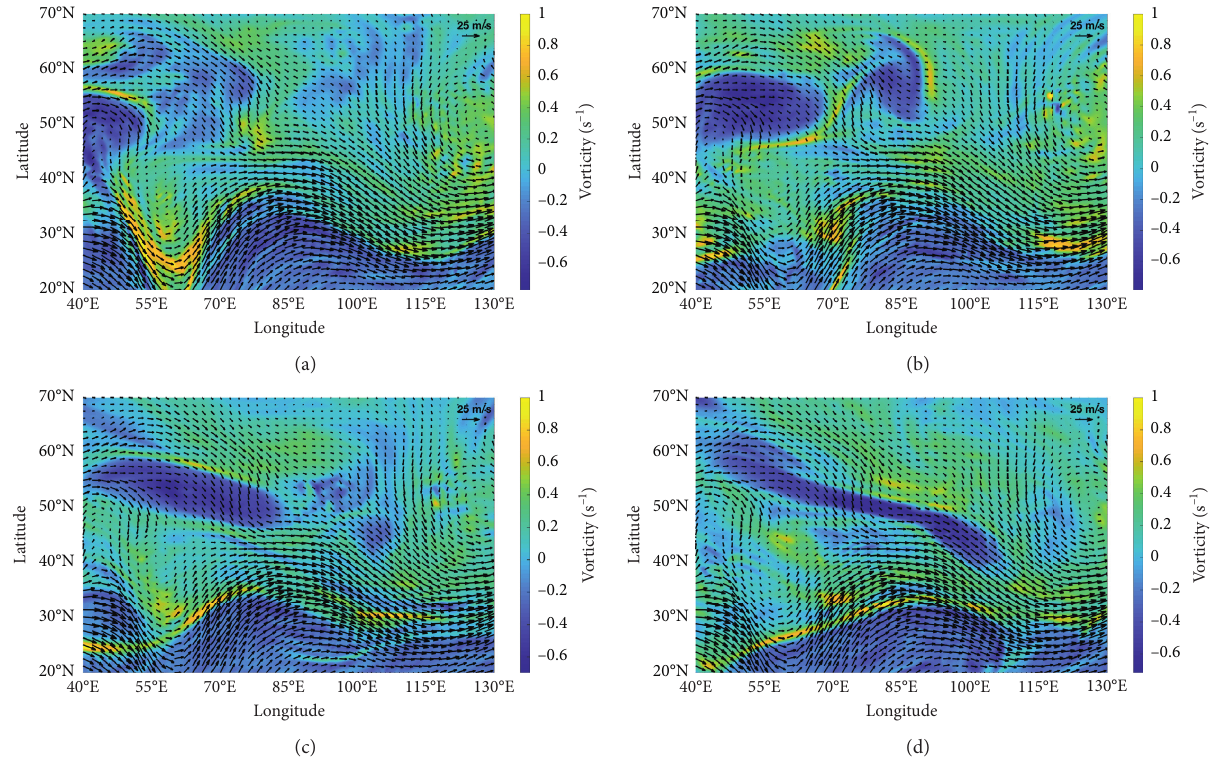
Figure 1: Four snapshots of the stratospheric 200hPa jet at time. (a) t � 1. (b) t � 24. (c) t � 48. (d) t � 60.